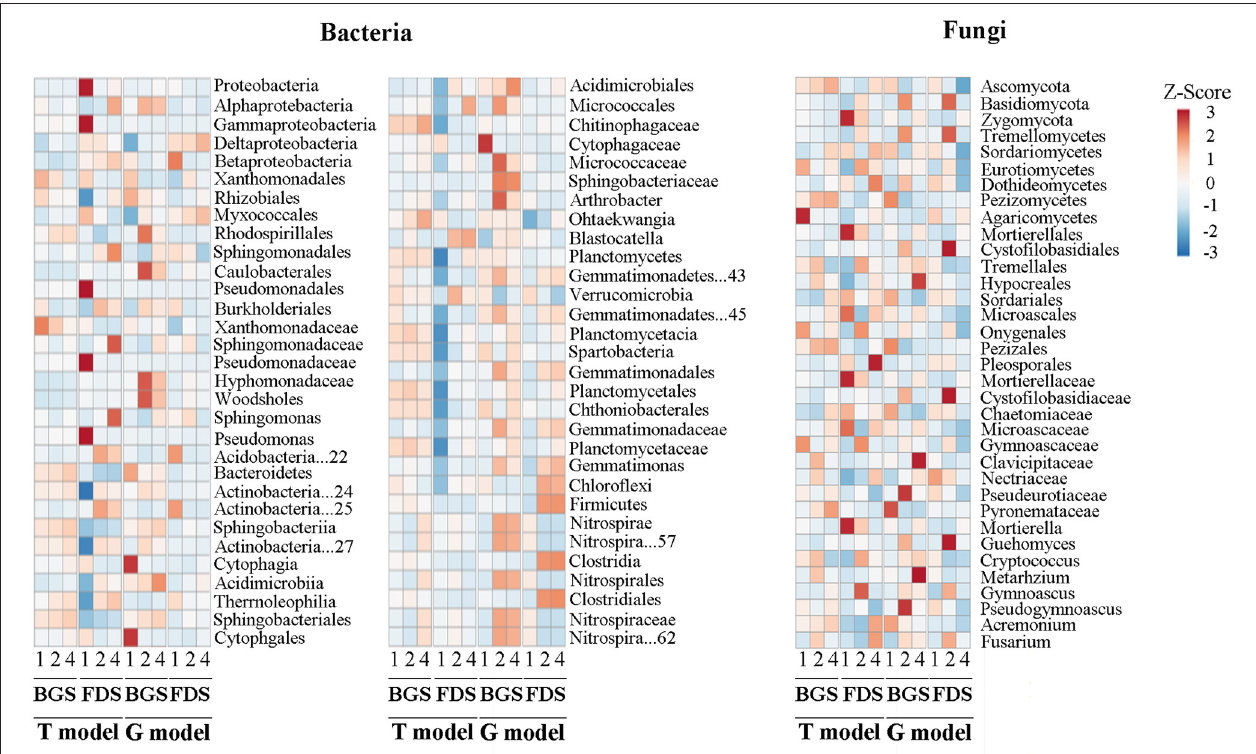
FIGURE 4 | The variation in the composition and structure of the microbial community at the taxon level between the intercropping patterns and between the development stages in the studied soils. 1, 2, and 4 indicate intercropping with 0, 1, and 3 species of aromatic plants, respectively, to facilitate regression analysis. BGS, branch growth stage; FDS, fruit development stage. T model, intercropping with aromatic plants in the clean tillage soil; G model, intercropping with aromatic plants in the natural grass